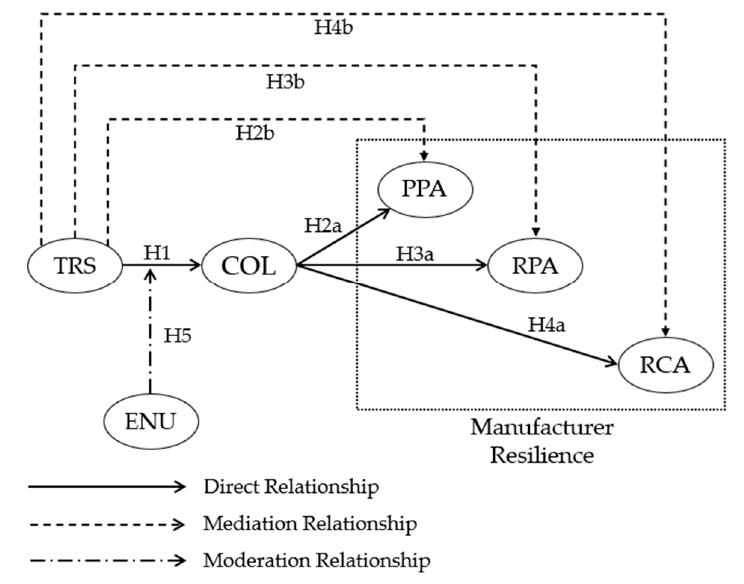
Figure 1. Theoretical model.